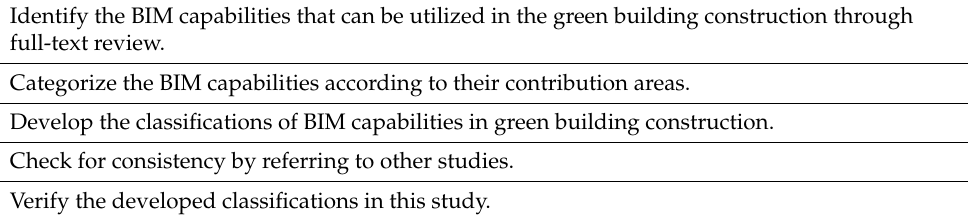
Table 3. Process of categorization